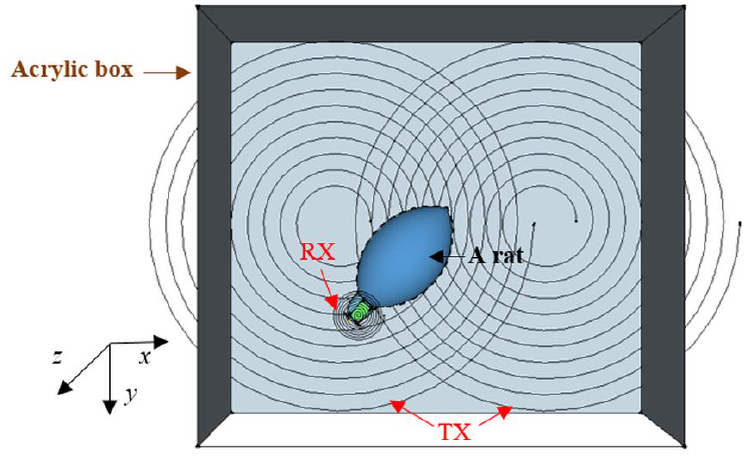
Figure 9. Two identical TX antennas were arranged 20 cm apart driven by the same power supply and identical amplifier circuitry.